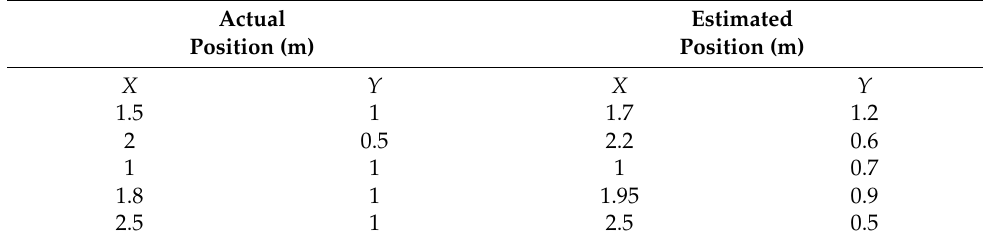
Table 2. Localization: x,y actual and estimated positions